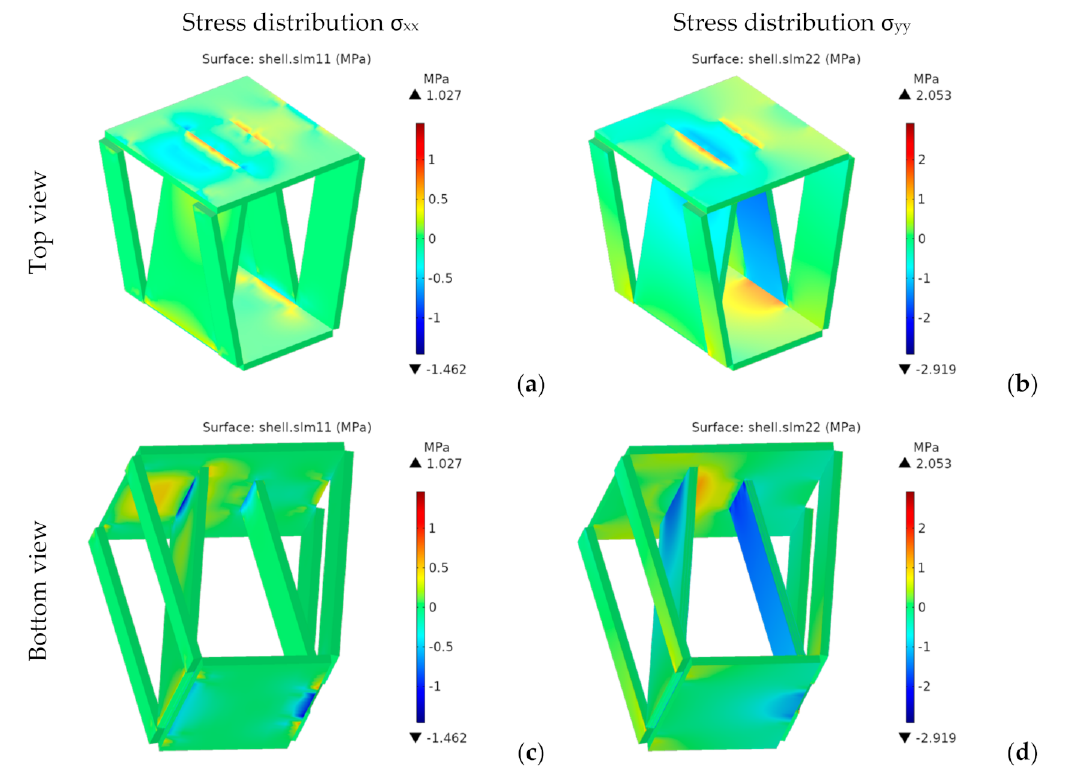
Figure 26. 4th design. Stress for ply orientation I [MPa] ( a , c ) σ xx ; ( b , d ) σ yy .